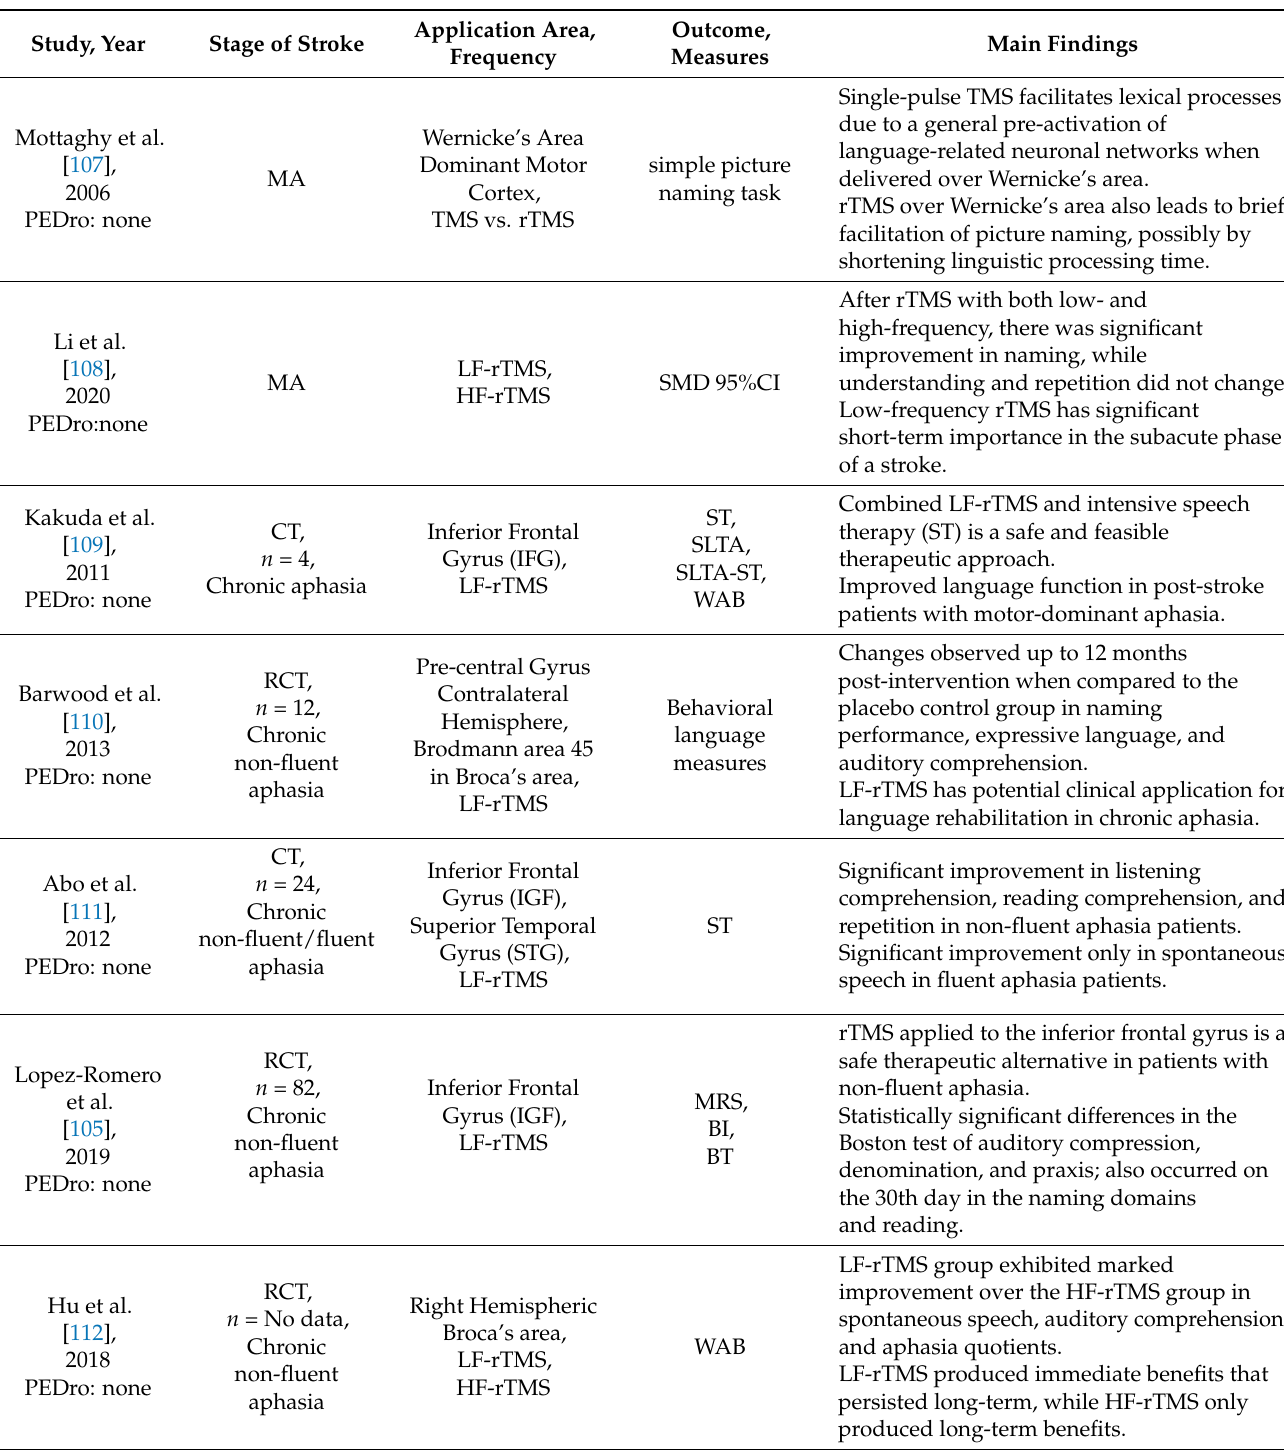
Table 4. Summary of potential improvements in speech and swallowing after using rTMS therapy in stroke patients in RCTs, meta-analyses (MA), and clinical trials (CT) with a valid measure of the methodological quality of clinical trials using